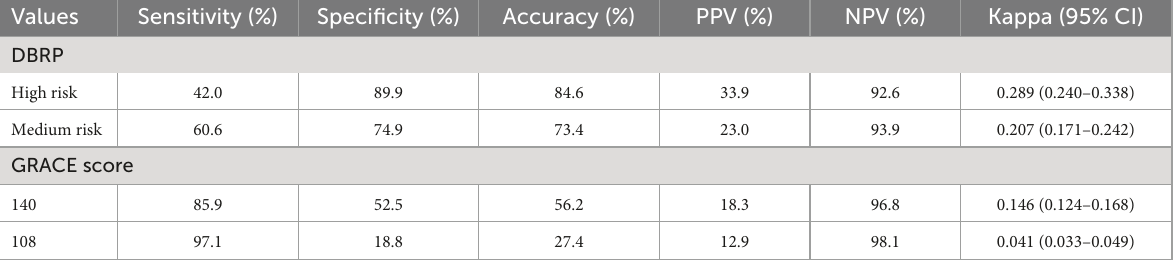
TABLE 3 Predictive efficiency for mortality of the DBRP and GRACE score in acute coronary syndrome patients.